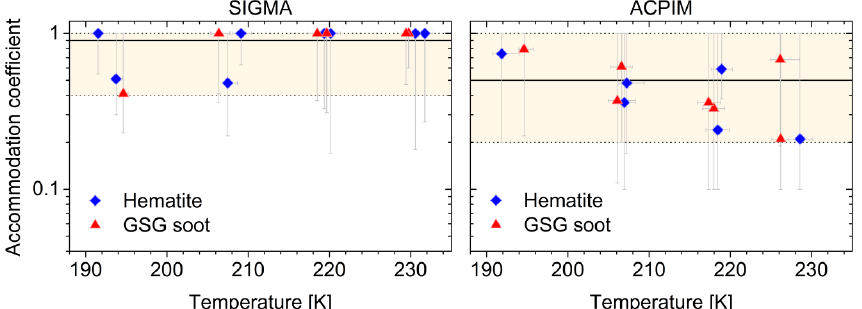
Fig. 6. Accommodation coefficients α ice obtained from SIGMA and ACPIM model calculations for the AIDA experiments listed in Table 3. Best-fit values relate to the median of the distributions of α ice values that were retrieved by the uncertainty analysis described in Sect. 5.1, while error bars indicate the respective lower and upper quartiles. Likewise, median as well as lower and upper quartiles were determined from the temperature distribution of each experiment and applied accordingly. The temperature-averaged α ice values obtained by SIGMA = 0 . 9 + 0 . 1 = 0 . 5 + 0 . 5 α SIGMA − 0 . 5 and ACPIM α − 0 . 3 are given by the solid black lines with the shaded region indicating their uncertainty.